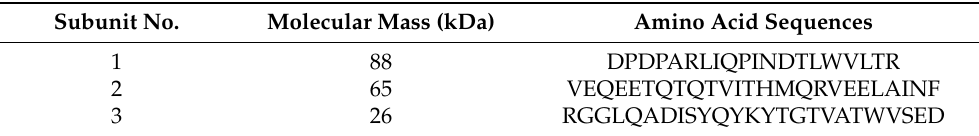
Table 3. N-terminal amino acid sequences of TTX binding protein subunits. Subunit No. Molecular Mass (kDa) Amino Acid Sequences 1 88 DPDPARLIQPINDTLWVLTR 65 26